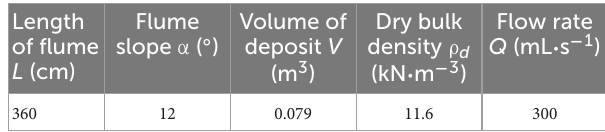
TABLE 1 The main parameters of the flume